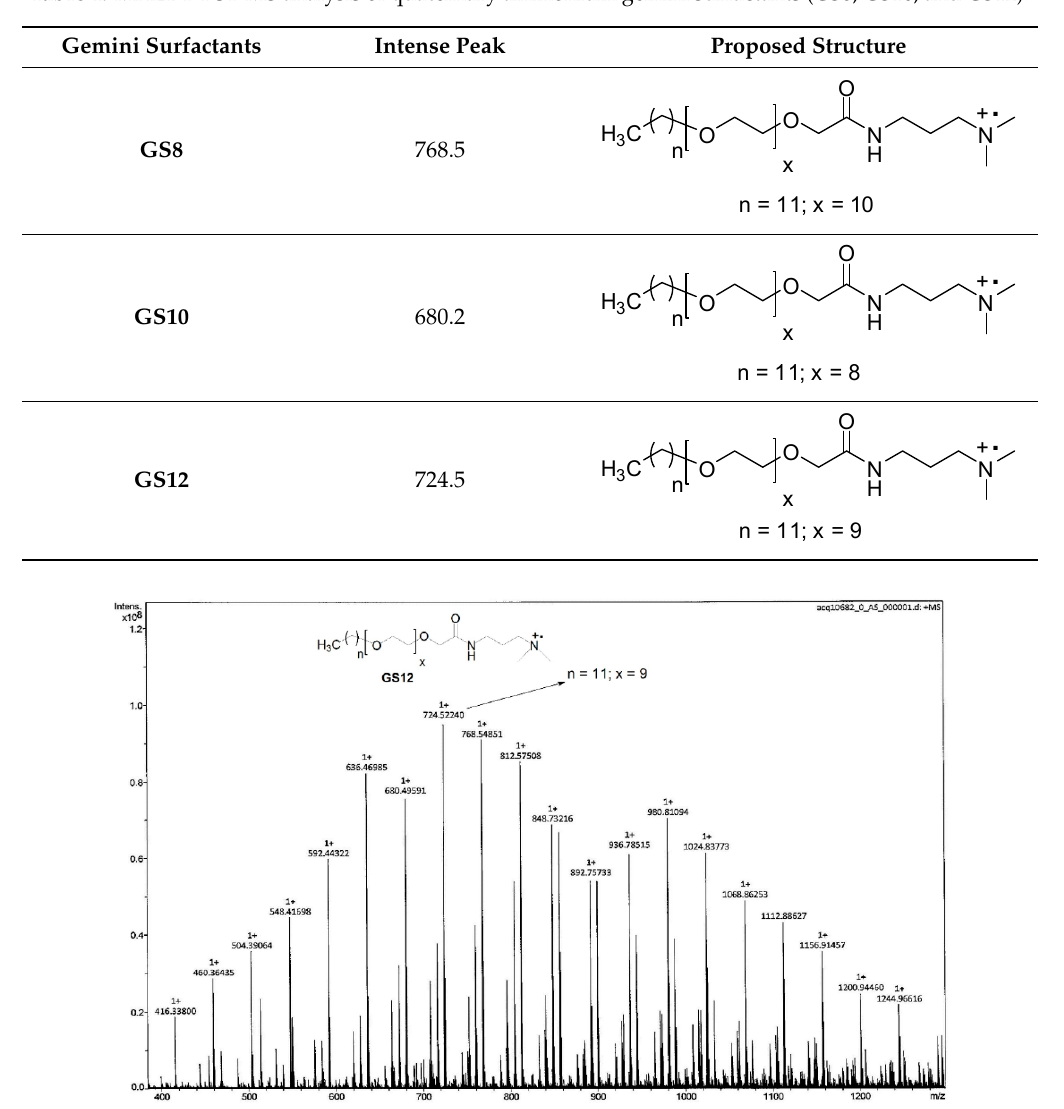
Figure 5. MALDI-TOF MS of quaternary ammonium gemini surfactants (GS12).